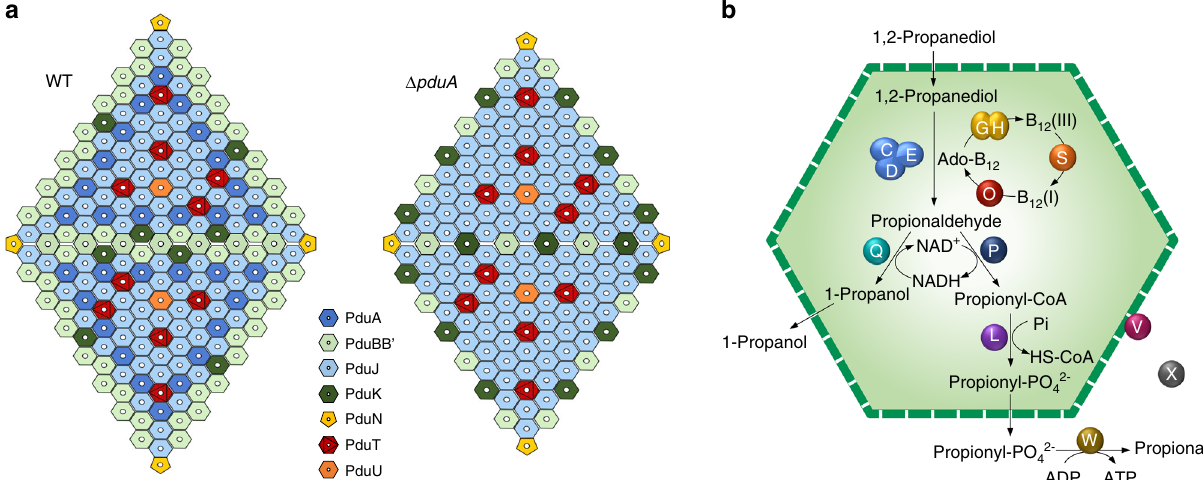
Fig. 4 Schematic models of the Pdu MCP shell and interior organisations. a Models for two adjacent Pdu MCP shell facets in the S . Typhimurium LT2- WT and LT2- Δ pduA . Note that the model construction is based on the number of shell proteins from the absolute quanti fi cation data, and the relative geometric arrangement remains speculative. PduM is not shown here because of its unknown structure and uncertain role. b Model for the organisation of catalytic proteins. PduCDEGHLOPQV function as components of the Pdu MCP, whereas our confocal data suggest that PduW and PduX are not integrated into the Pdu MCP